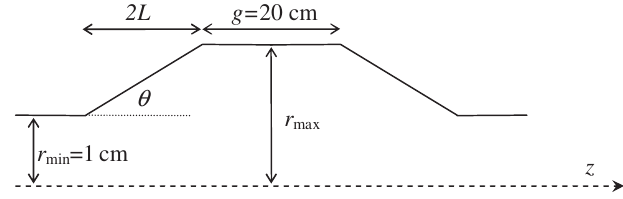
FIG. 2. Geometry used for ABCI calculations. Structure is axially symmetric and mirror symmetric in the z direction.